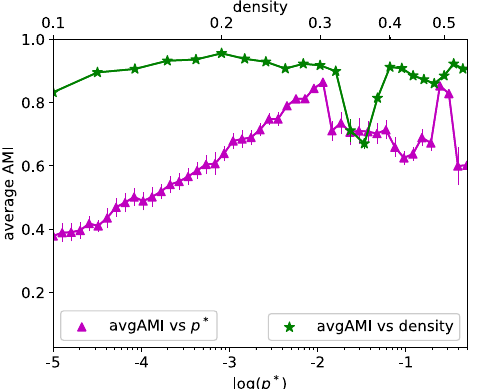
Fig. 8 Average Adjusted Mutual Information (AMI) between the best partitions of the network validated by the various null models. Error bars represent standard deviations over choices of null model pairs. Values are plotted for fi ltered networks obtained with the same signi fi cance threshold p * (magenta triangles) or of equal density (green stars). The latter option reveals a higher concordance among the null models.